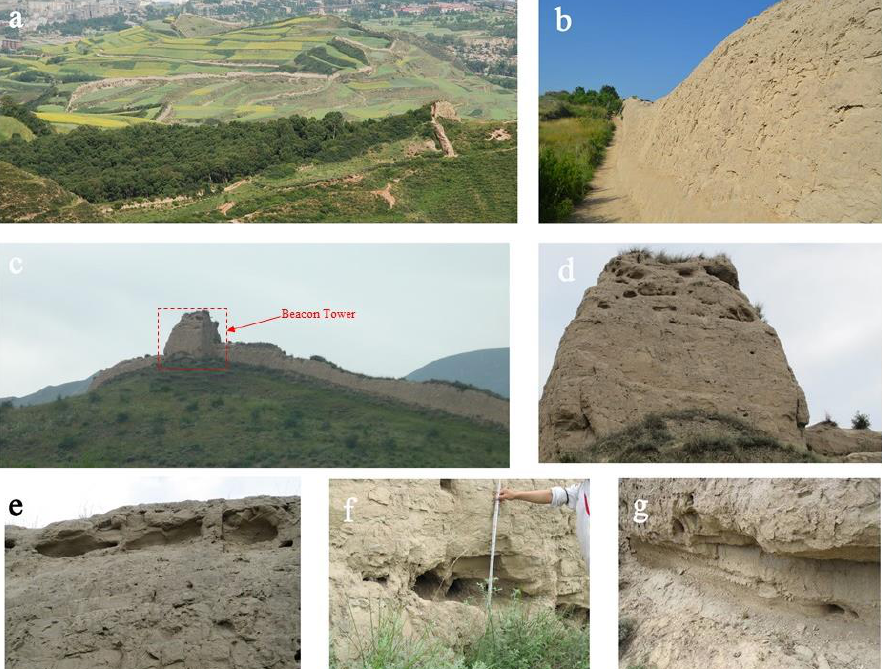
Figure 4. Wind erosion damage to the wall ( a ) The Wall built along the ridge; ( b ) Relative well- preserved Wall in spite of long-term nature erosion; ( c ) Wall and beacon tower on the ridge; ( d ) sapping of beacon tower; ( e ) sapping at upper part of the Wall; ( f ) measurement of sapping area; ( g ) sapping at bottom of the Wall.